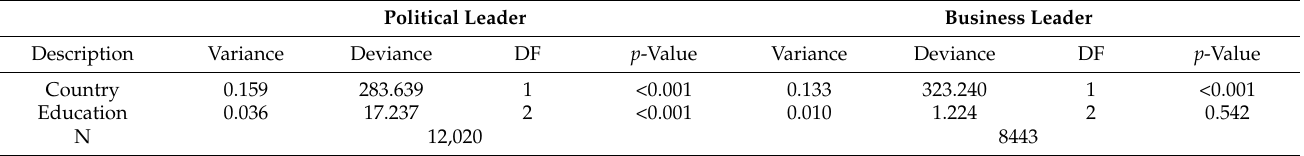
Table 3. Variance estimates and tests of the multilevel varying-intercepts and varying-slopes models, the WVS. Political Leader